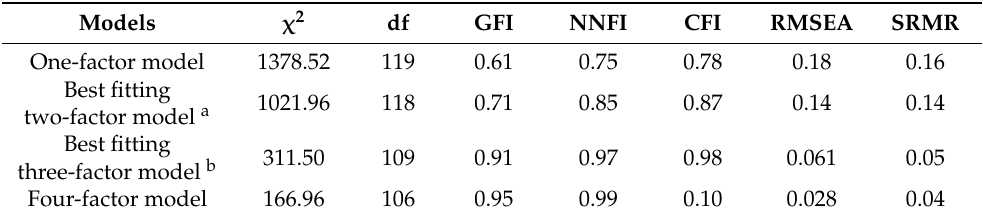
Table 2. Goodness of fit